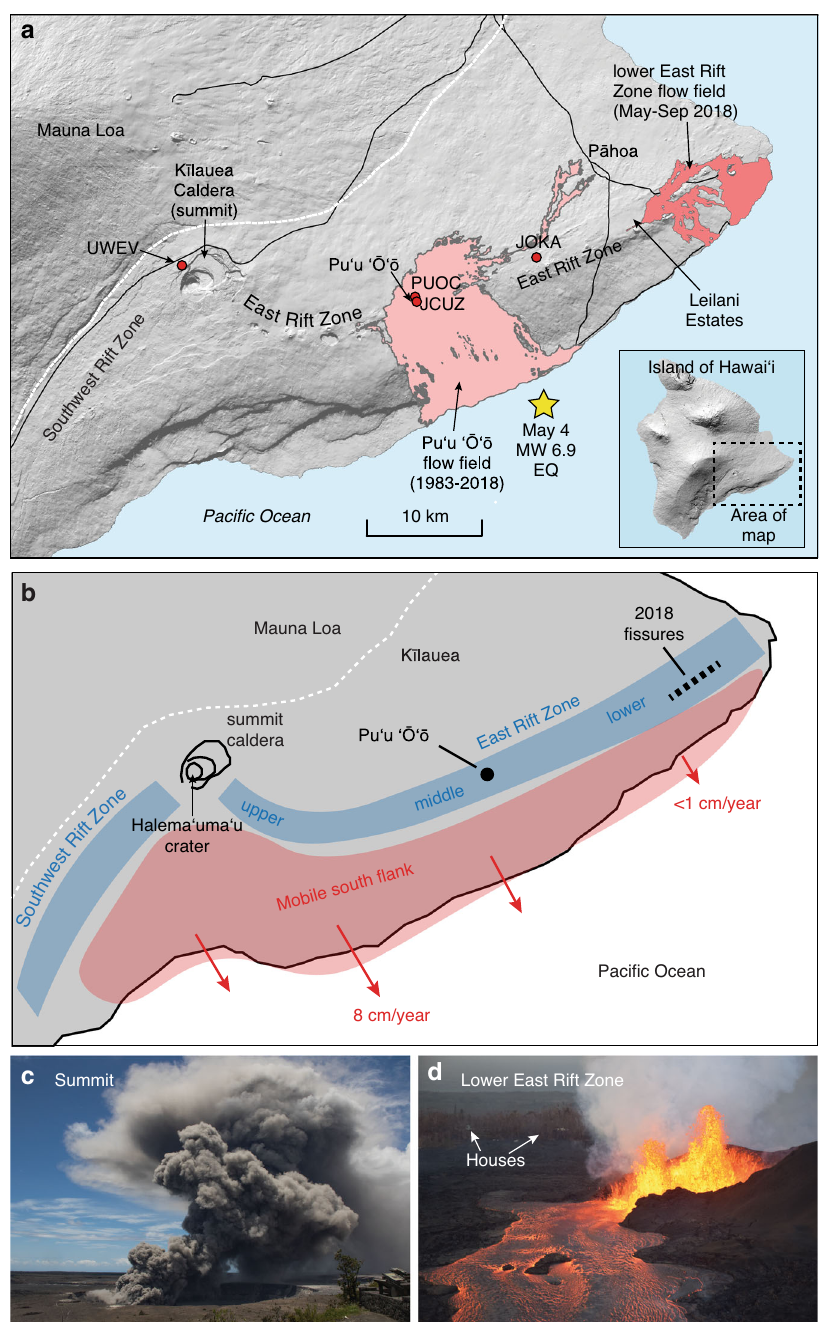
Fig. 1 Location map for K ī lauea volcano. a Map of K ī lauea Volcano, on the Island of Hawai ʻ i. The Pu ʻ u ʻ Ō ʻ ō eruption (1983 – 2018) produced a 144 km 2 lava fl ow fi eld in the middle East Rift Zone (ERZ). The May – September 2018 eruption occurred on the lower ERZ, ~40 km from the summit caldera. A large portion of the summit caldera fl oor subsided during the 2018 eruption. UWEV, PUOC, JCUZ, and JOKA are continuous GPS stations. The star shows the epicenter of the May 4 M w 6.9 earthquake. b Schematic structural map of K ī lauea Volcano, showing the summit region and two rift zones. The mobile south fl ank exhibits steady southeast motion, and is tightly coupled with the rift zone magmatic system. c Small ash-rich explosive event at the summit, during the collapse of Halema ʻ uma ʻ u crater, on May 15, 2018. USGS photo. d Fountaining (~50 m high) at fi ssure 8, the dominant vent in the lower East Rift Zone on June 5, 2018. Residences in Leilani Estates subdivision are visible in the background. USGS